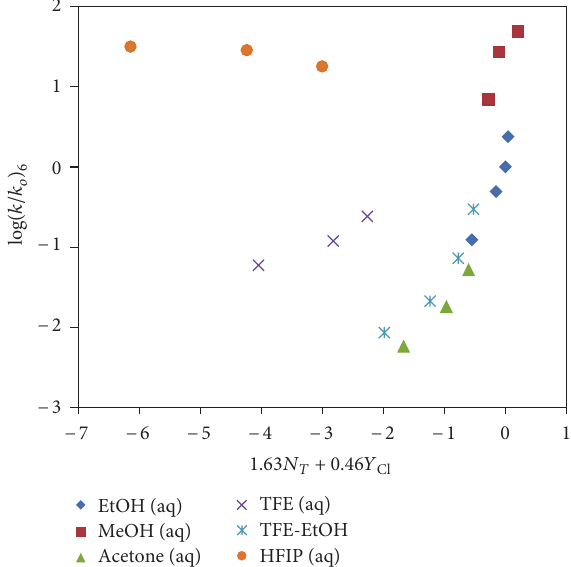
F 3: e plot of log mate ( 6 ) against 1.63 solvents studied. e points for TFE-H included in the correlation. ey are added to show the extent of their deviation from the